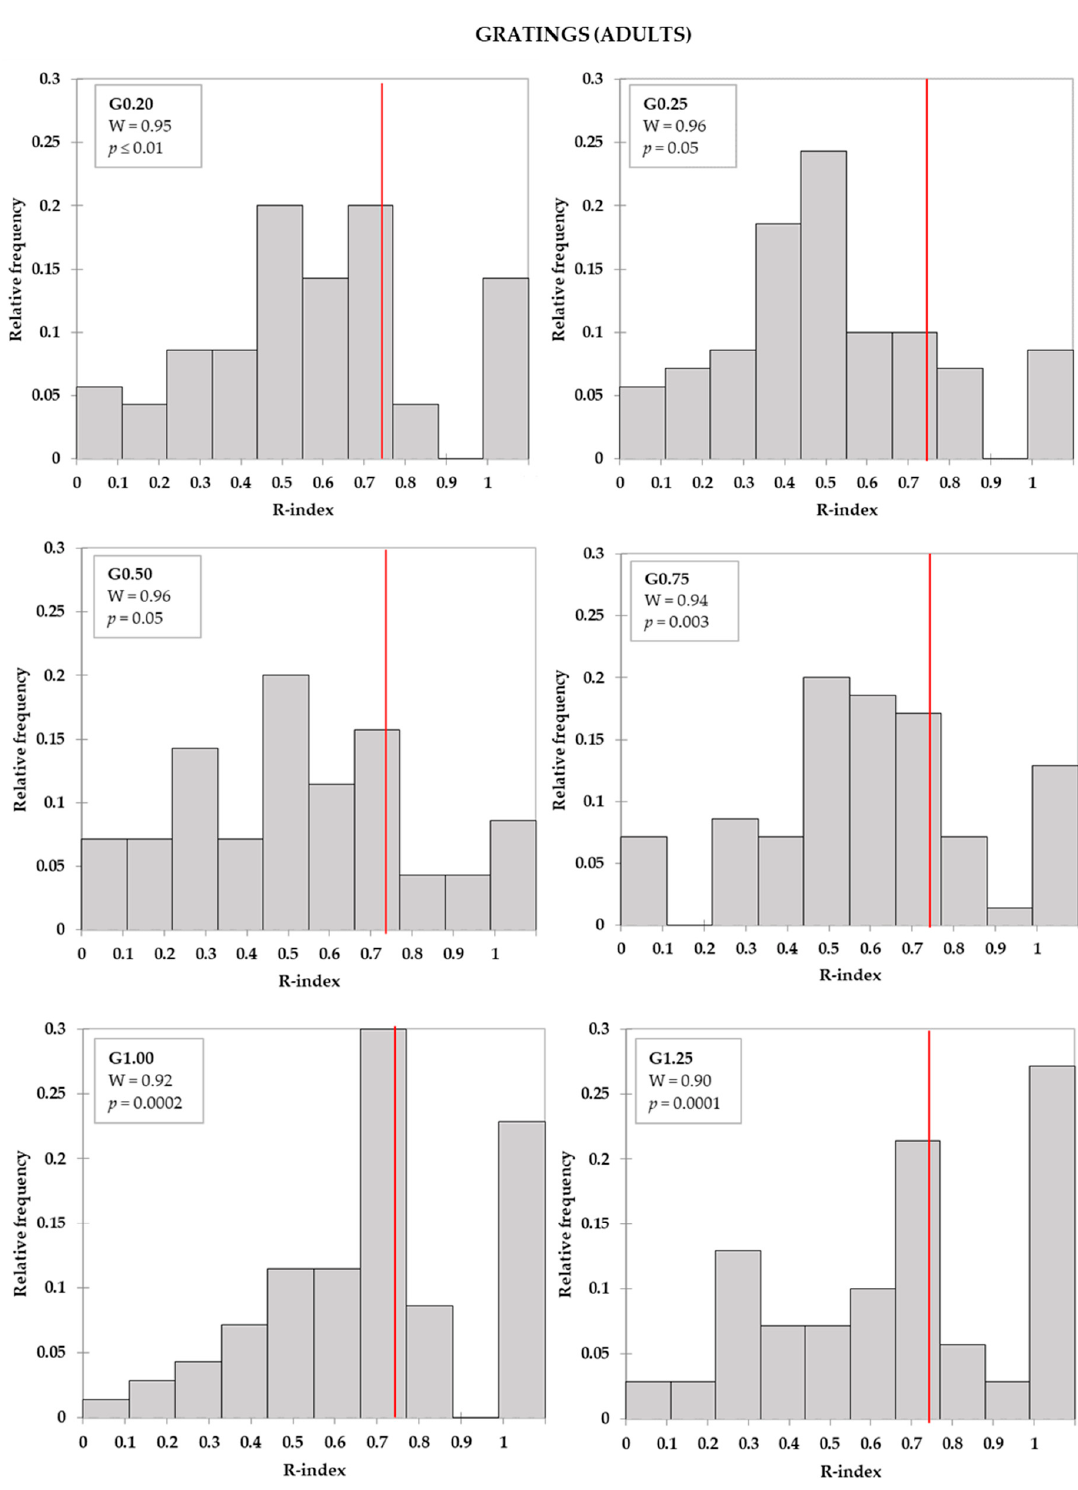
Figure 3. Adult R-index distributions for gratings (G). The vertical lines indicate the R-index cut-o ff s for discrimination ( R = 0.74). The boxes show the Shapiro-Wilk test (W) statistics and respective level of significance.